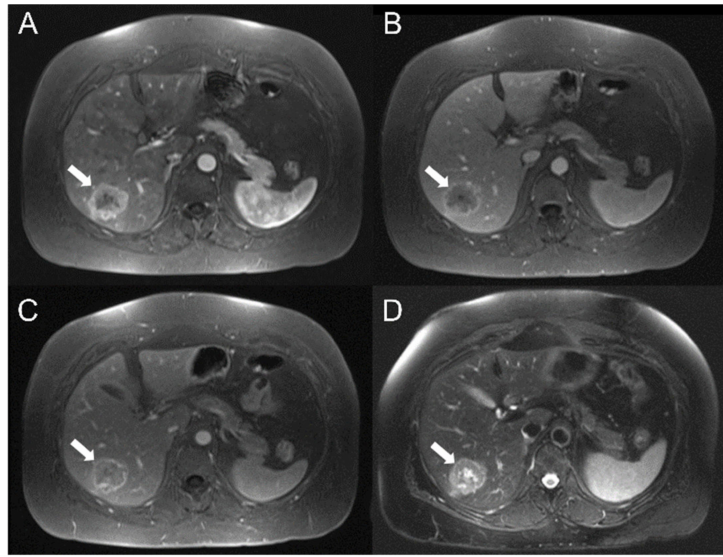
Figure 3. Moderately differentiated HCC (G2) in the right hepatic lobe of a 54-year-old white female. Results showed hypointense mass on axial dynamic study ( A – C ), and hyperintensity on the lesion central part on fat-suppressed axial T2-weighted sequence ( D ) (white